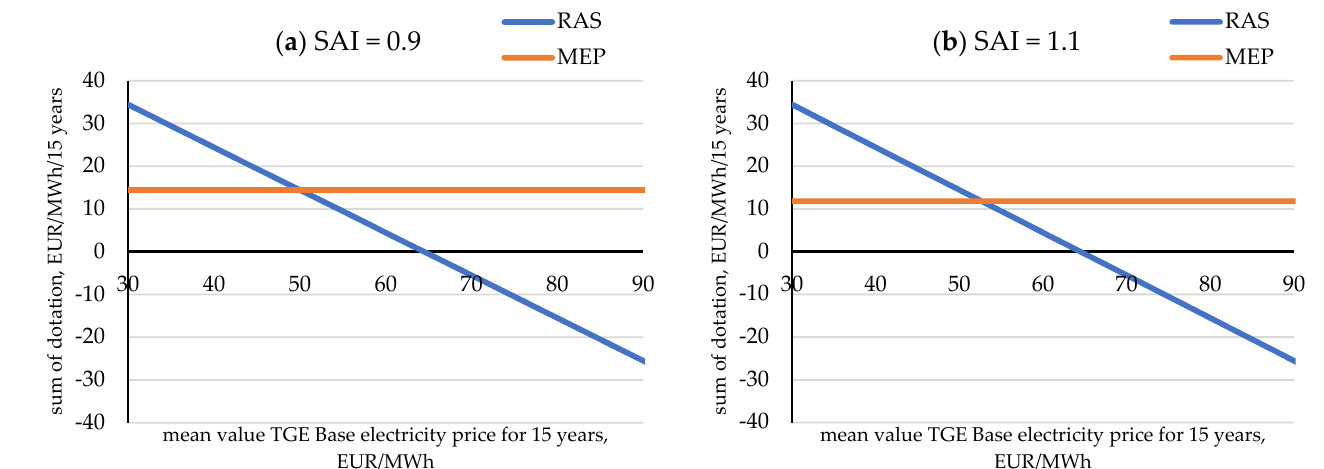
Figure 13. The balance curve between the negative and positive balance (RAS) compared to the My